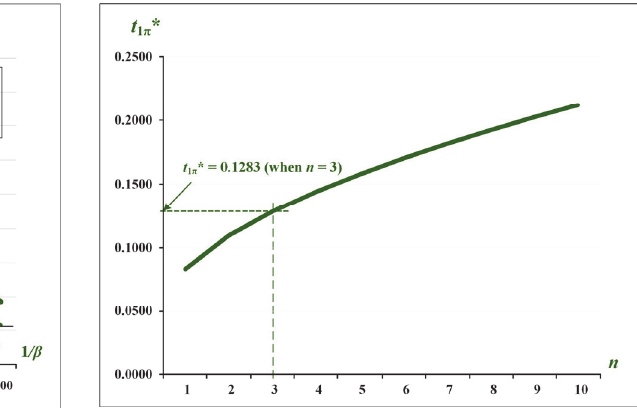
Fig. 10. The impact of differences in 1/ β along with x on E [ TCU ( t 1 π *)]